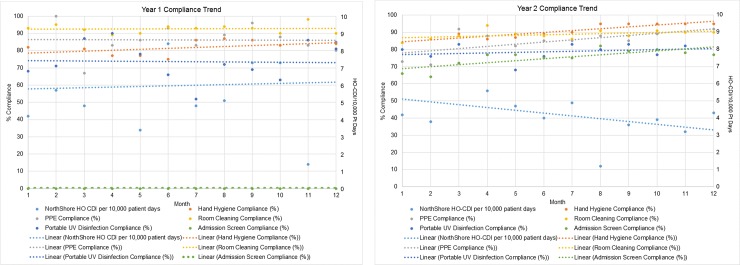
a. and b. Compliance with infection control practices designed to reduce risk of HO-CDI (3a represents Period 1 and 3b represents Period 2; S2 Table).